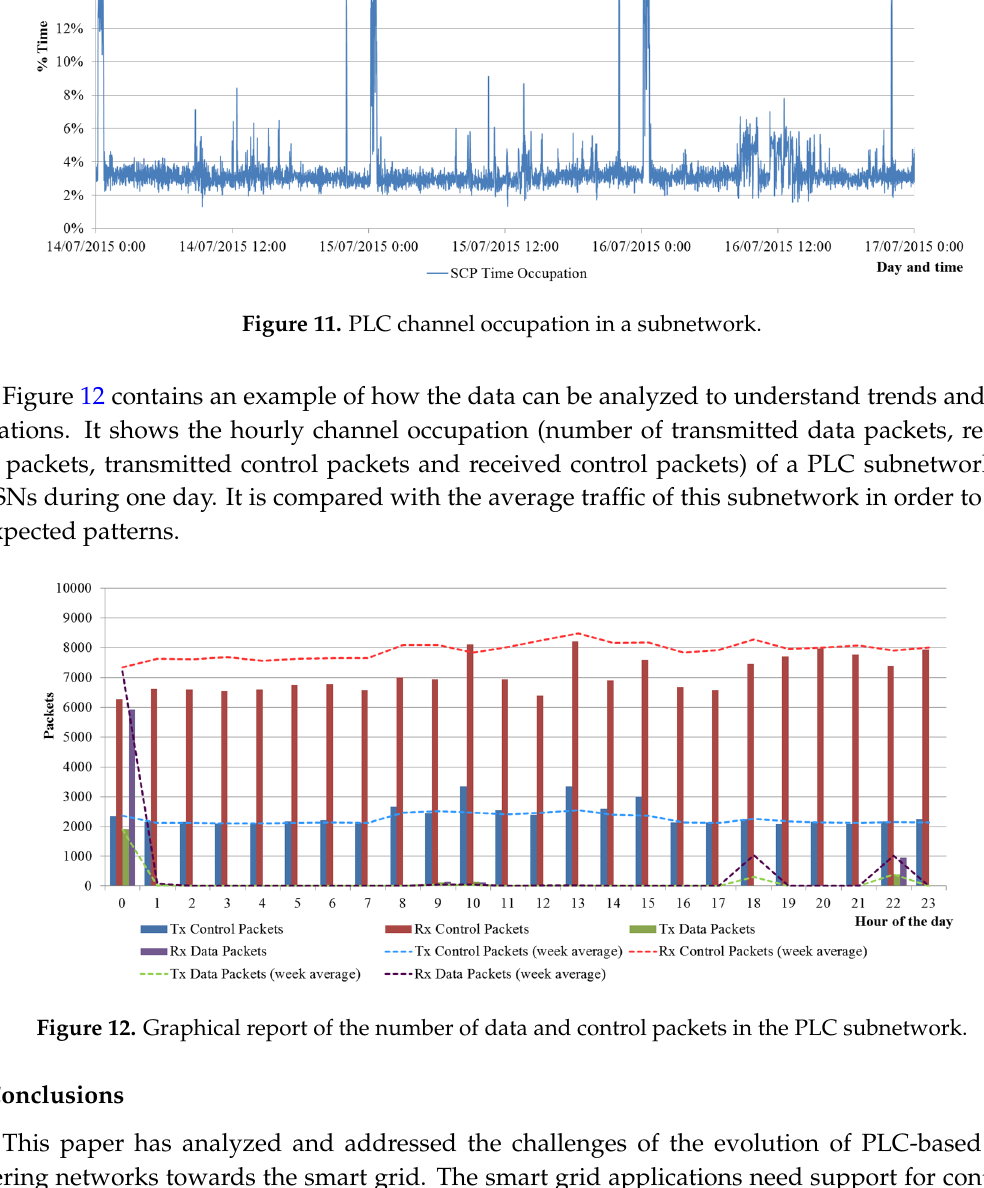
Figure 9. Topology SNs connected to the BN; terminals and switches) evolution of a PLC subnetwork. Figure 10 shows the evolution of the number of control and data packets in the subnetwork. It gives information about the use of the communication resources provided by the subnetwork and the distribution of traffic along time. Figure 10. Control and data packets (transmitted –TX ‐ and received –RX ‐ ) in a ITU ‐ T G.9904